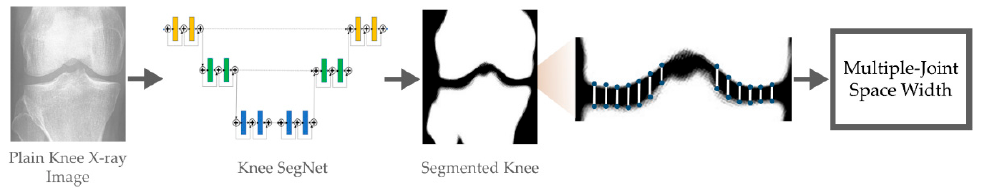
Figure 1. Flow diagram of the multiple-JSW automatic measurement.